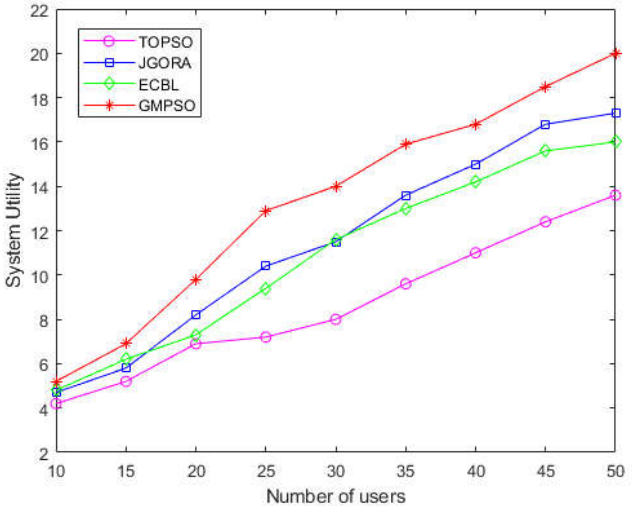
Figure 3. System utility against different numbers of users.